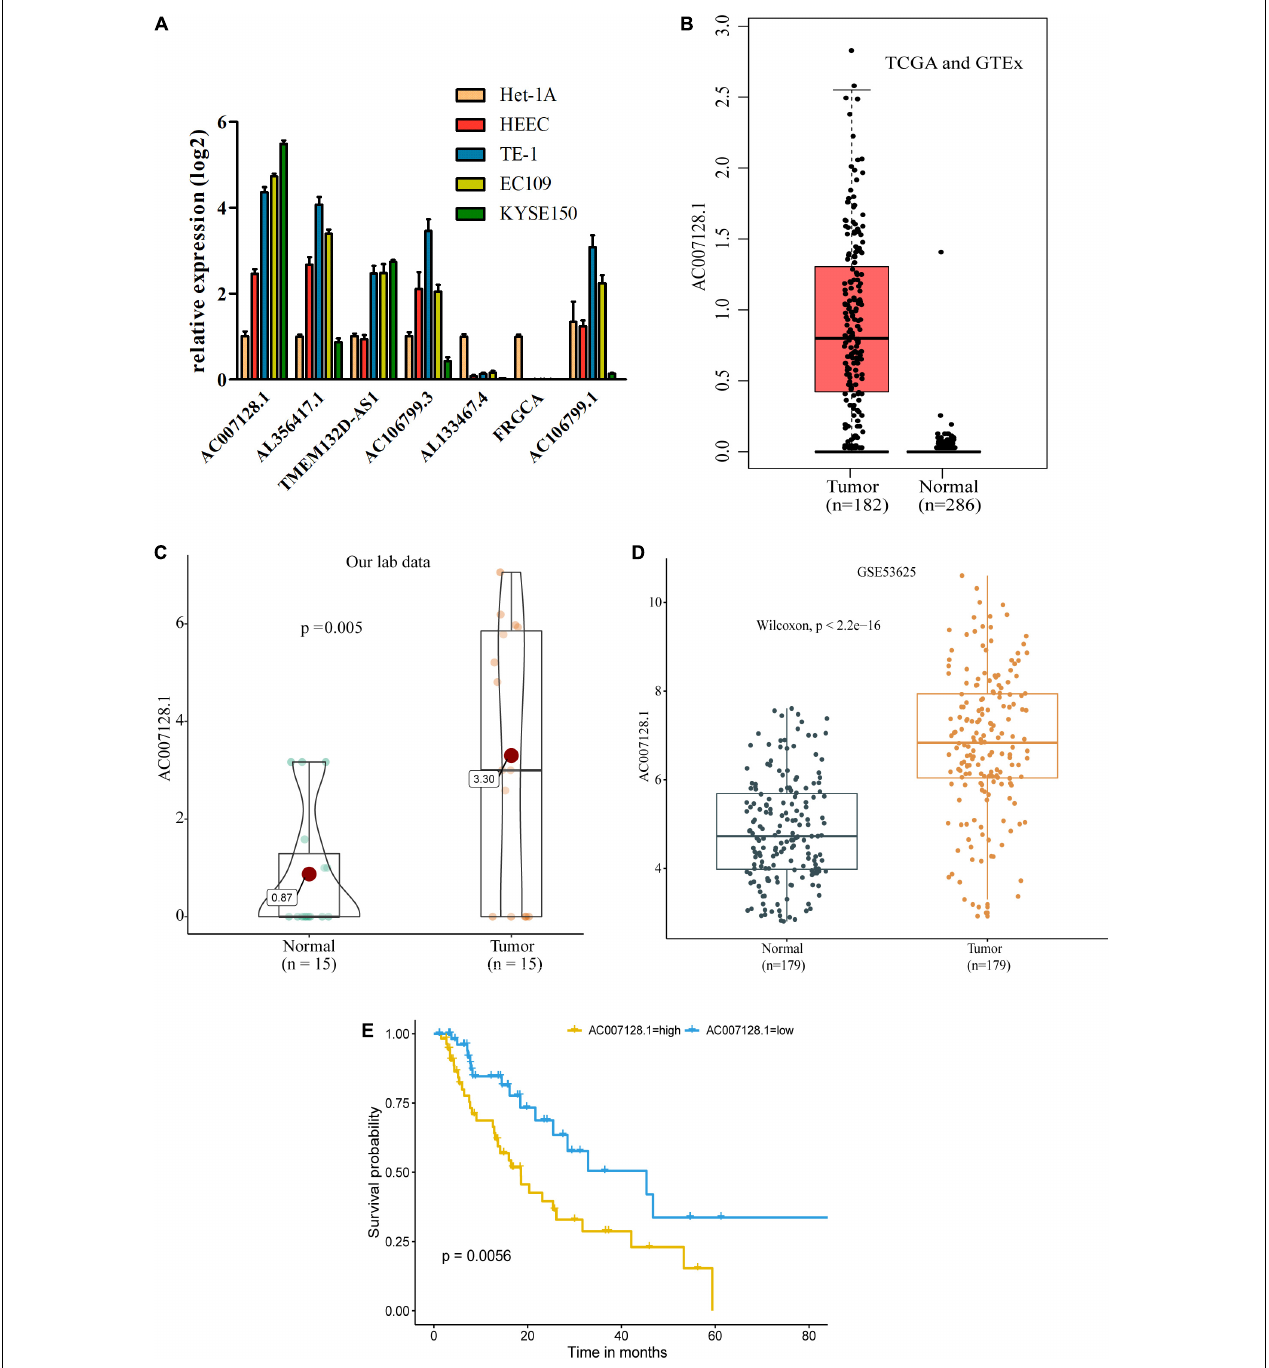
FIGURE 3 | AC007128.1 is up-regulated and linked to poor prognosis in ESCC. (A) Comparison of seven lncRNA expressions in ESCC and normal cell lines. Het-1A and HEEC represent normal cell lines, and others represent tumor cell lines. (B–D) Relative expression of AC007128.1 in ESCC tissues was analyzed by using GEPIA: http://gepia.cancer-pku.cn (B) , our lab (C) , and GEO datasets (D) . (E) KM survival analysis of ESCC patients with high or low AC007128.1 expression (defined by the median) in TCGA. Statistical analysis was performed using the two-sided log-rank test.